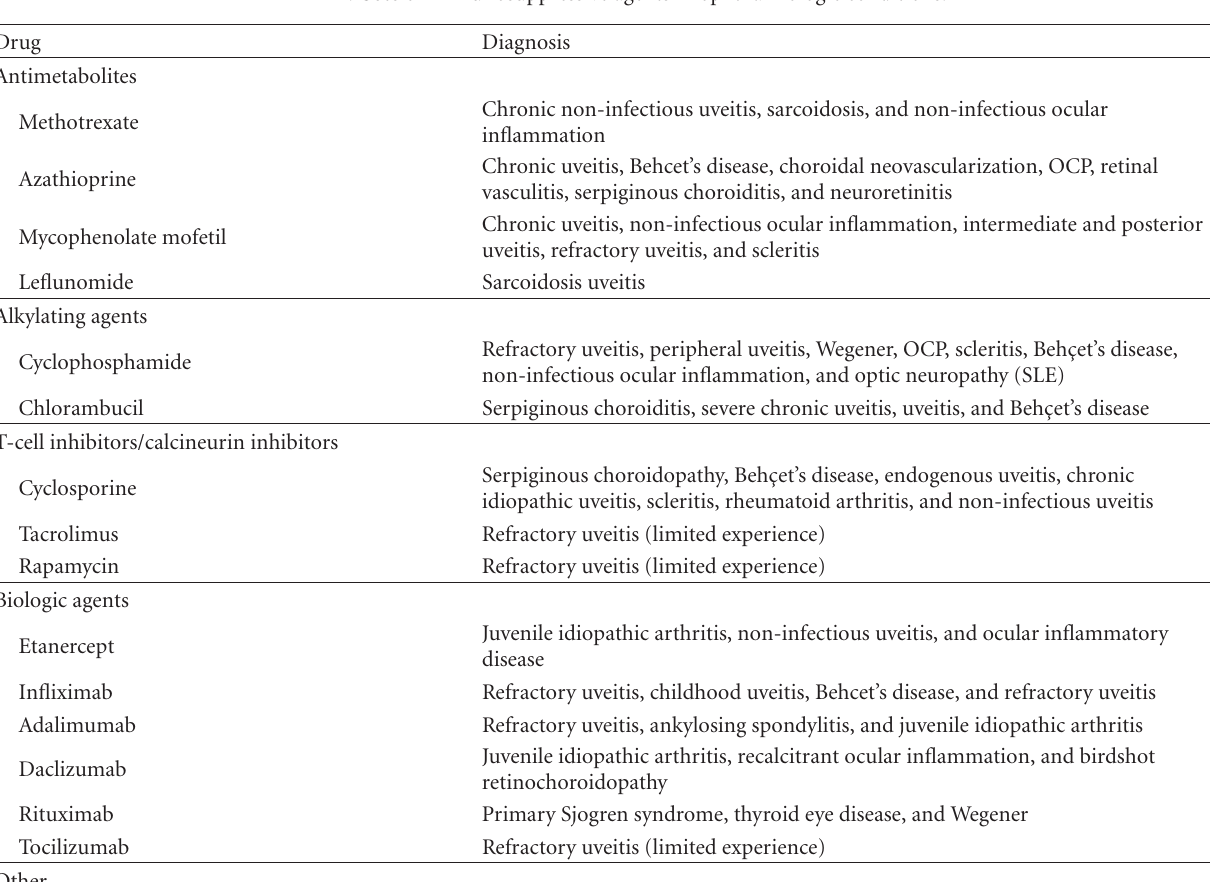
Table 2: Uses of immunosuppressive agents in ophthalmologic